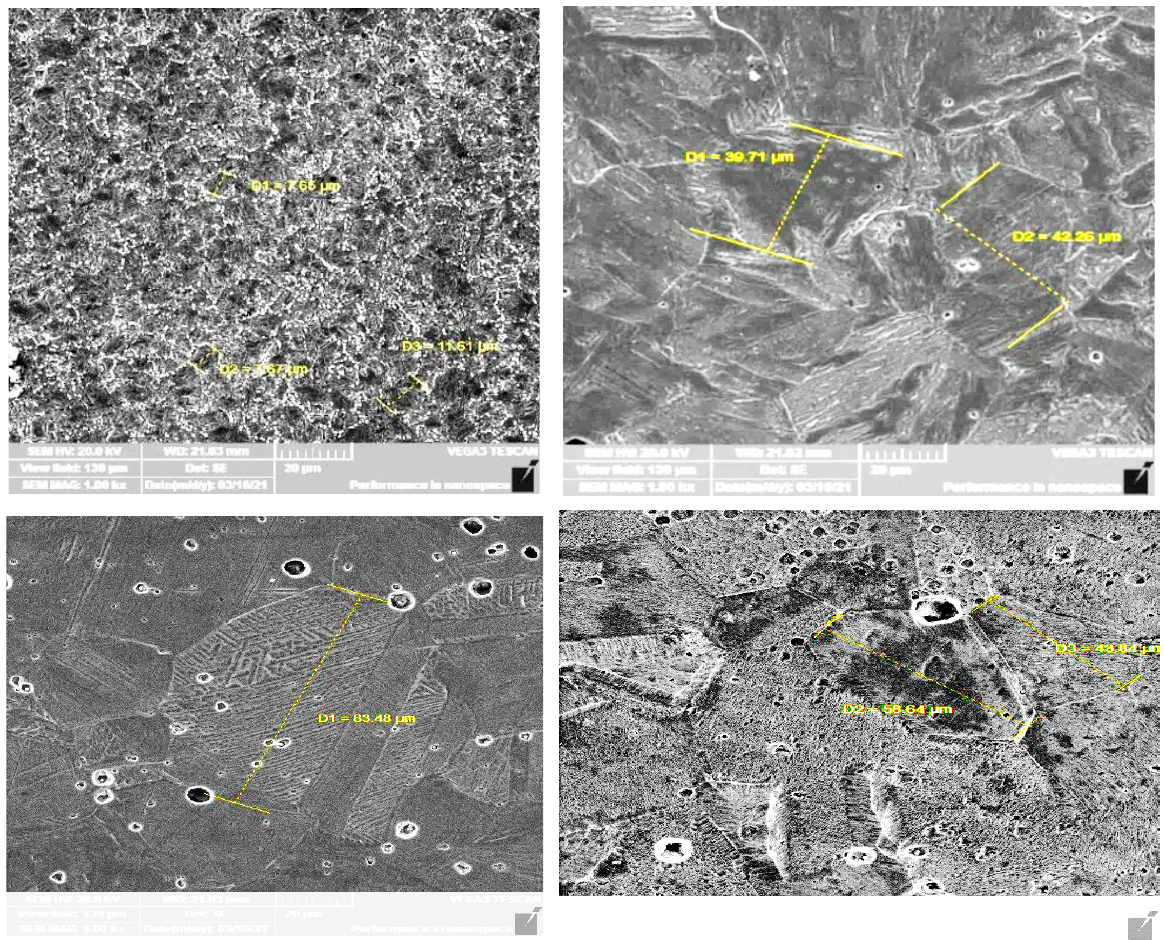
Figure 5. Scan electron microscope magnification 1K× for the Martensitic and austenite stainless steel grades S1 and S3 before and after the heat-treatment process. Table 3. Surface microhardness, average surface roughness, and wettability for the stainless steel grades, before and after the heat-treatment